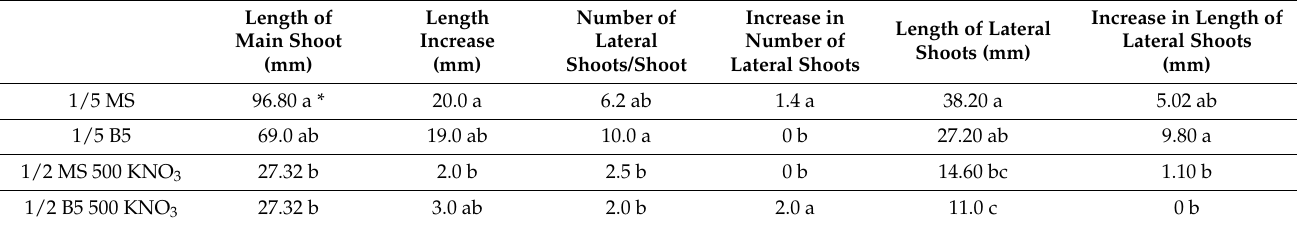
Table 3. Influence of medium type on the growth and development of Aldrovanda vesiculosa shoots in vitro in the second